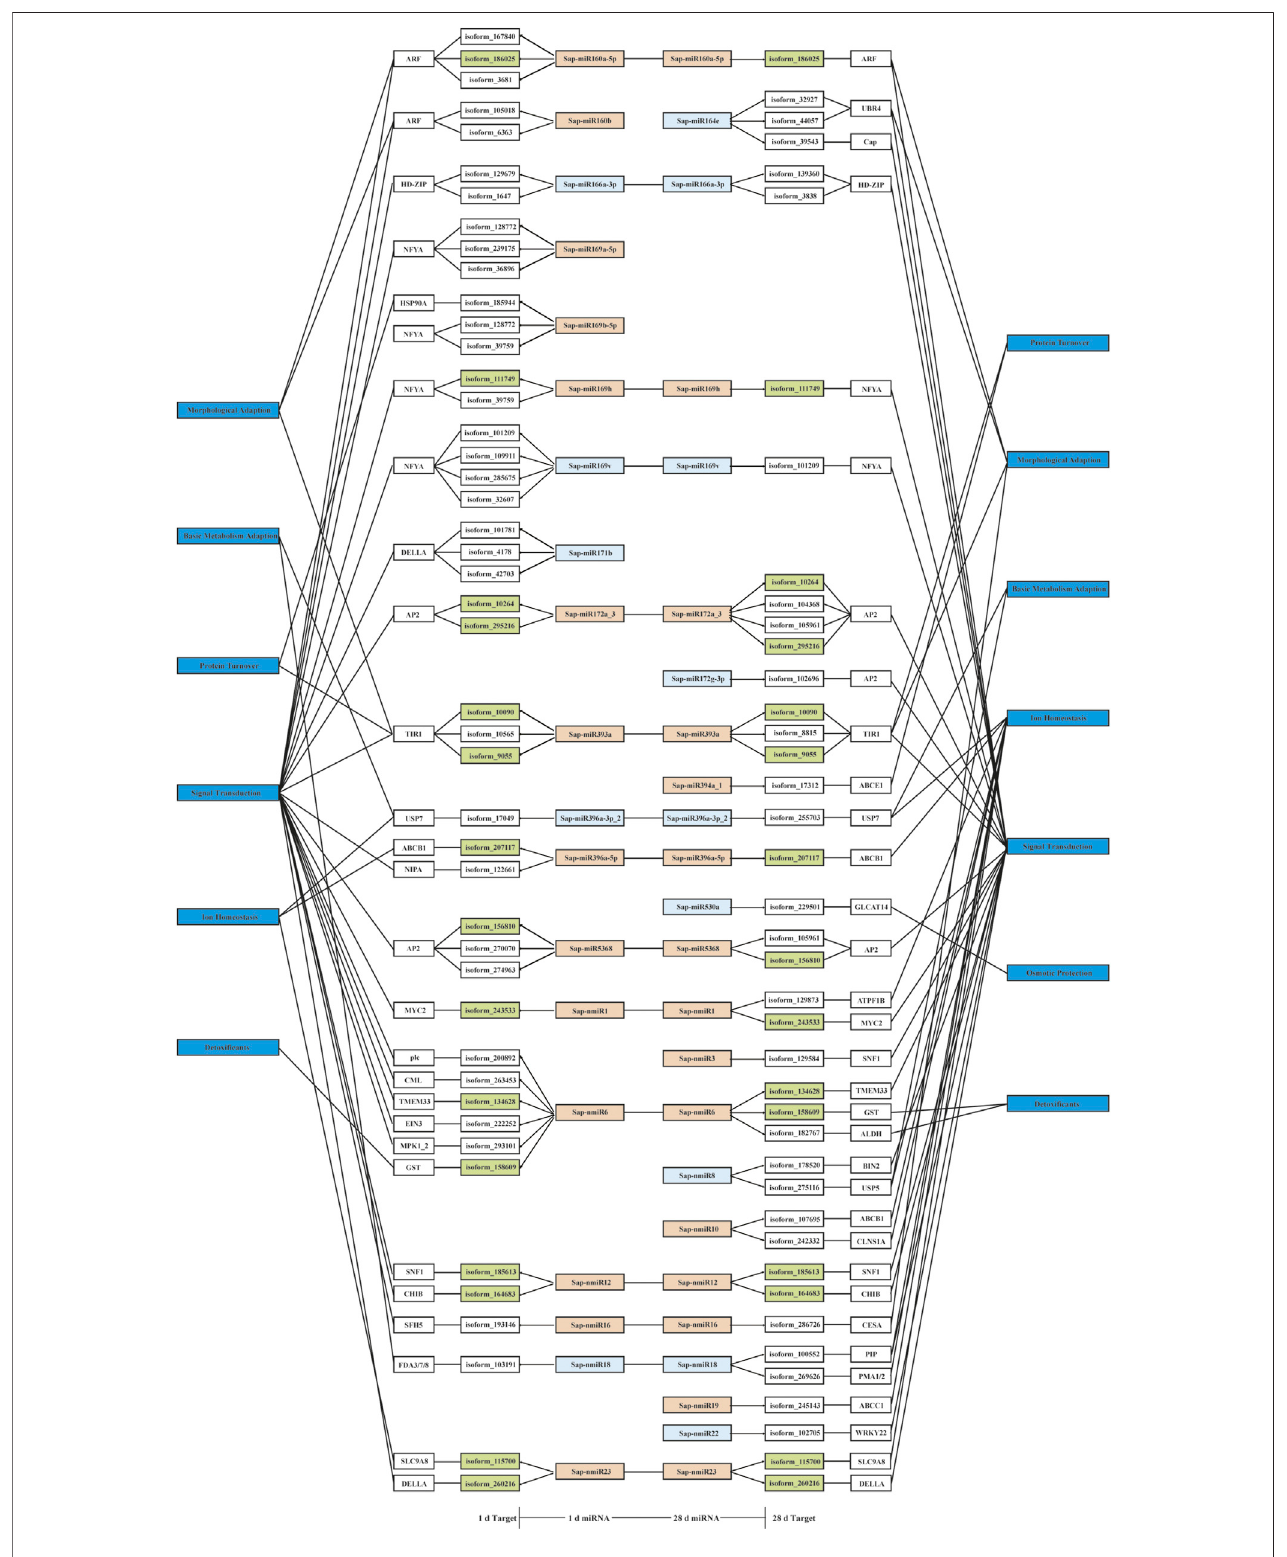
FIGURE 8 | A proposed regulatory network of negatively related Sonneratia -speci fi c miRNA-target pairs. The color of the miRNA box indicates the type of expression pattern: orange, down regulated; light blue, up-regulated. Green box indicates that targets were negatively regulated by the respective miRNAs at two time points (1 and 28 days) of salt